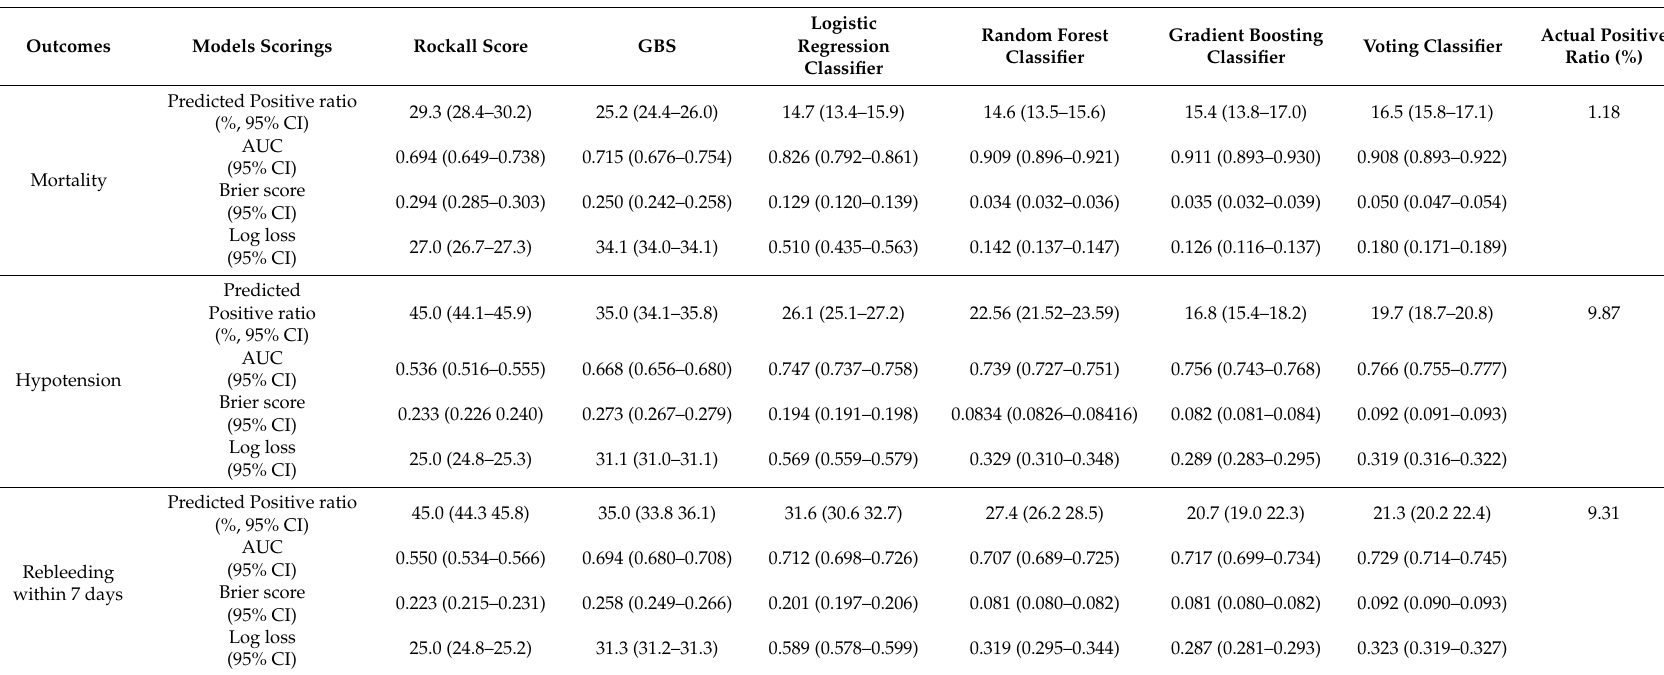
Table 2. The performance of models for predicting mortality, hypotension, and rebleeding within 7 days evaluated by the predicted positive ratio, AUC, brier score, and log